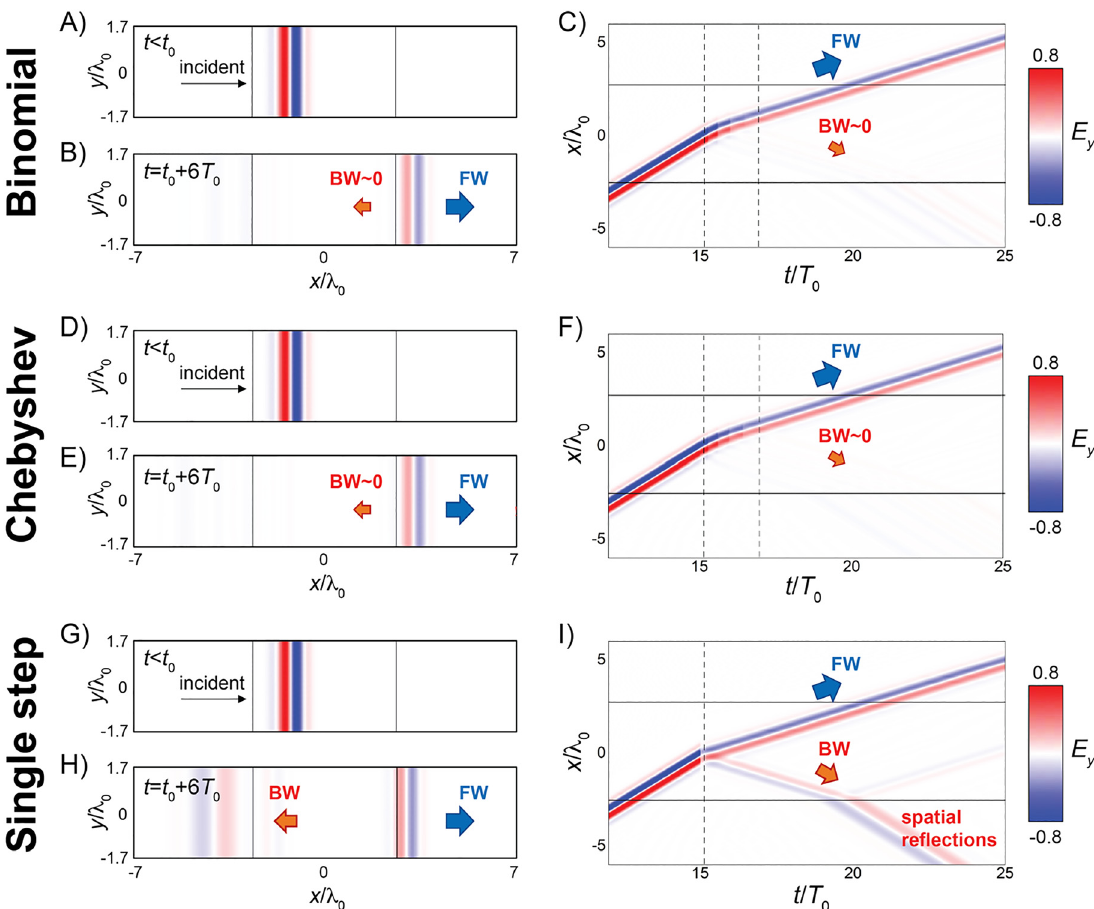
Figure 8: Spatial discontinuity between two stationary media with n i = 1 and n e = 2. (A), (B) Numerically computed instantaneous field maps (normalized electric field) at two-time instants (before and after the initial and final temporal boundaries, respectively), by assuming a central region − 2 . 5 λ 0 < x < 2 . 5 λ 0 where the refractive-index pro fi le is modulated in time according to the binomial design (with parameters given in the caption of Figure 2). (C) Corresponding space-time map (normalized electric fi eld). The continuous and dashed lines indicate the spatial and temporal boundaries, respectively. (D), (E), (F) As in panels (A), (B), (C), respectively, but for the Chebyshev design (with parameters given in the caption of Figure 5). (G), (H), (I) As in panels (A), (B), (C), respectively, butinforasingle-stepmodulation,wheretherefractiveindexofthecentralregionisabruptlyswitchedfrom n i to n e atthetemporalboundary t 0 = 15 T 0 , and then maintained